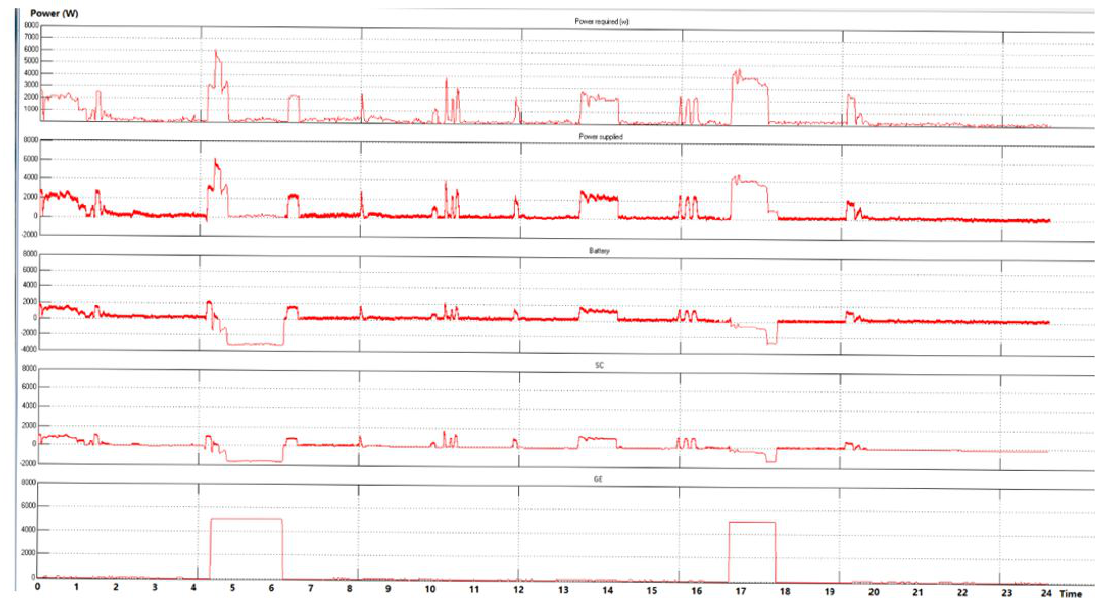
Figure 8. Summer load optimization